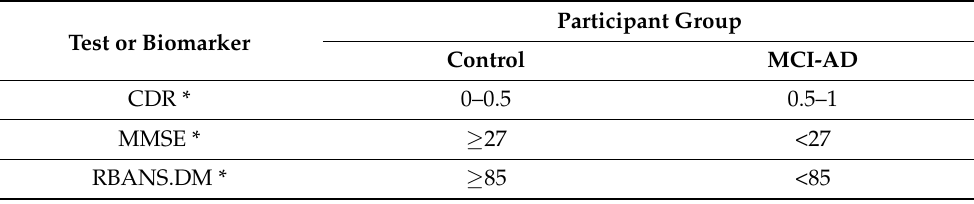
Table 1. Clinical and neuropsychological criteria for participants’